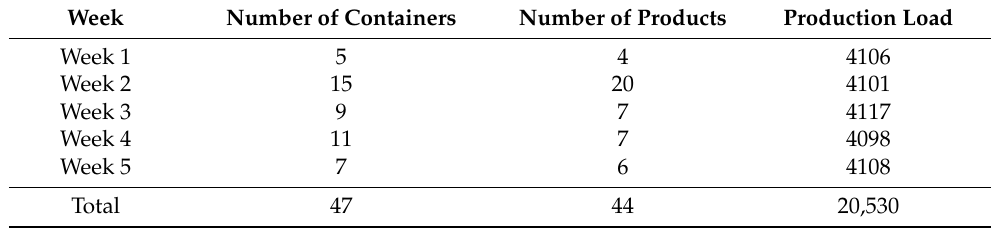
Table 5. Summary of the result for Case